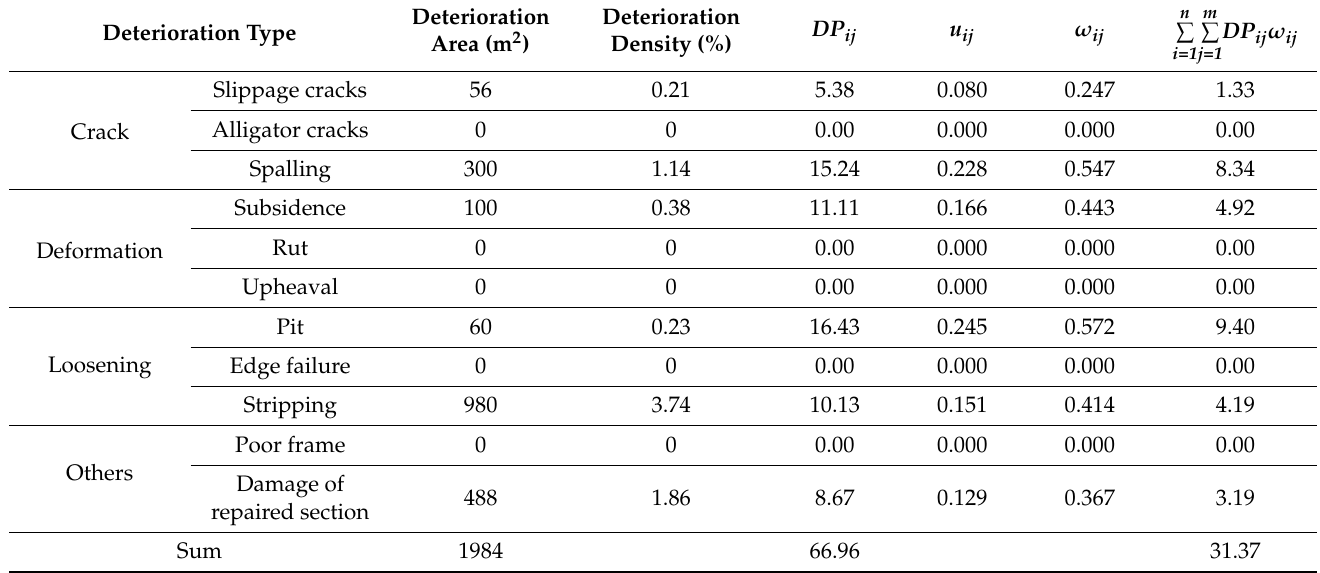
Table 2. An example of calculating PCI using AnQing